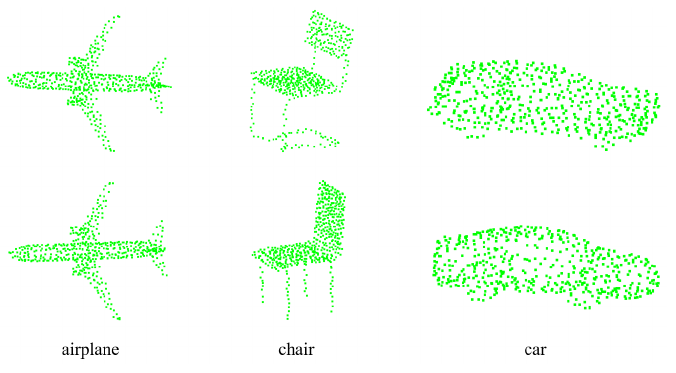
Figure 4. Example of ModelNet40 samples.